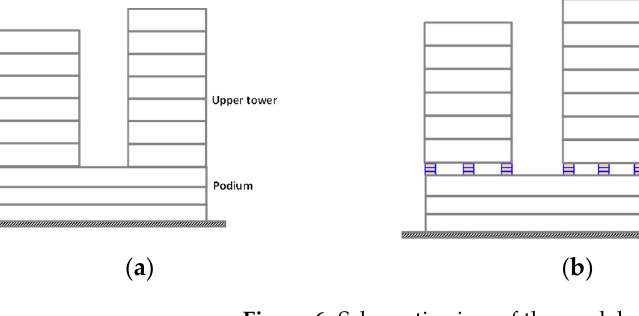
Figure 6. Schematic view of the models. ( a ) Model 1, known as ‘anti-seismic structure’; ( b ) Model 2, known as ‘isolation structure’; ( c ) Model 3, known as ‘isolation + shock absorption’ structure.